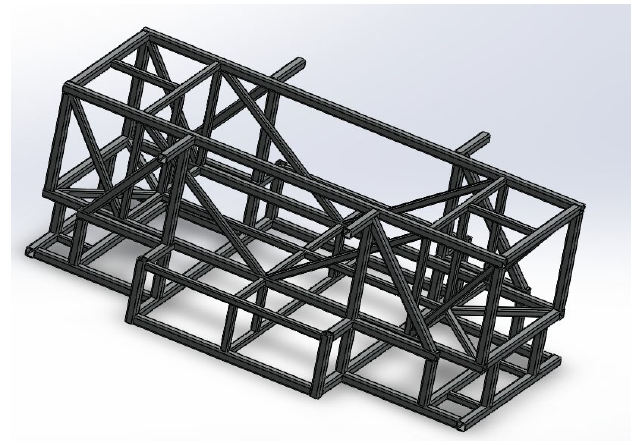
Figure 18. Example of a step of the structural analysis performed using Solidworks: frame displacements.